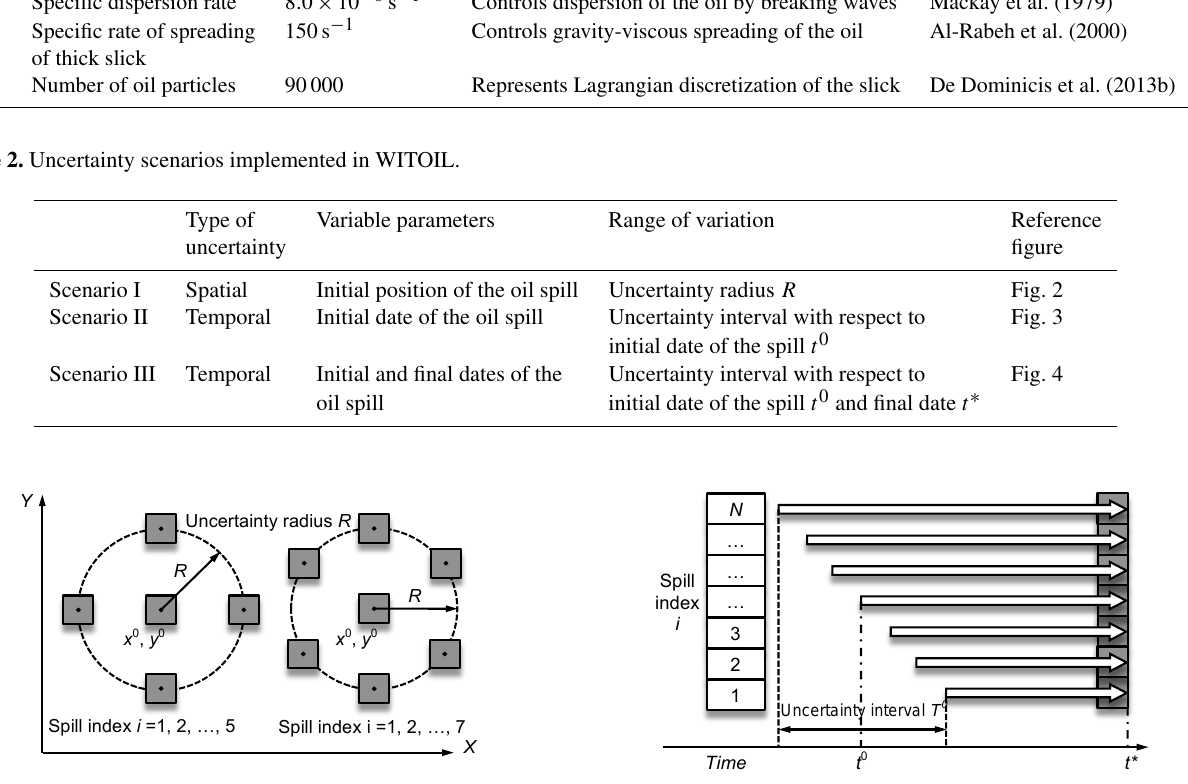
Figure 2. Uncertainty Scenario I with respect to the initial position of the oil spill: cross (left) and hexagon (right) configuration.